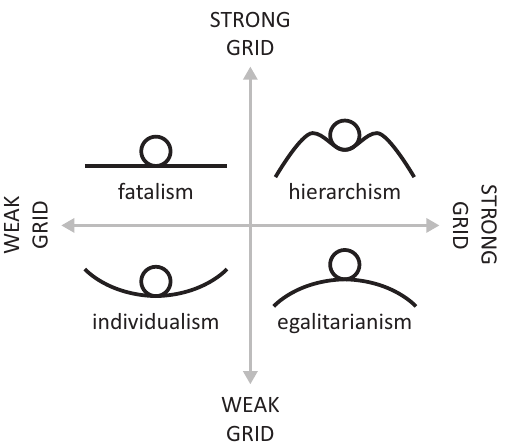
Figure 1. Group and grid diagram and pluralistic ratio‐ nalities of cultural theory. Source: Authors based on Hartmann (2012), Schwarz and Thompson (1990), and Snel et al.